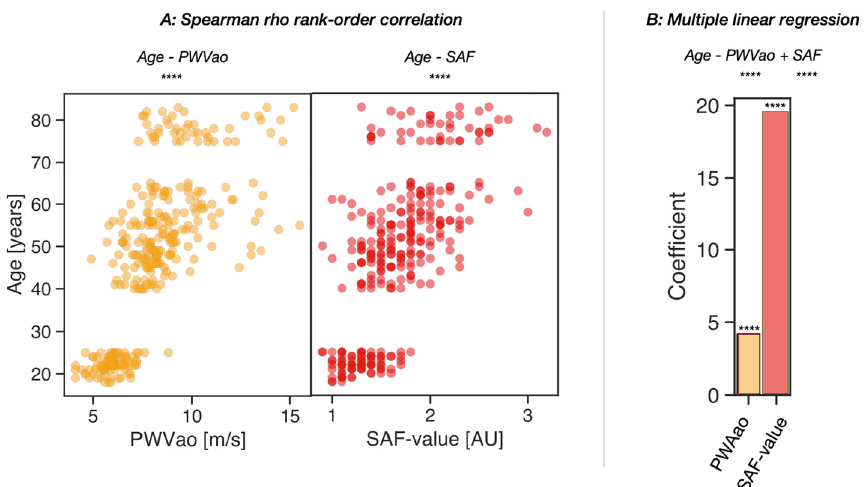
Figure 1. Associations between age and PWVao (yellow) and skin SAF value (red), respectively, in the cohort ( n = 309). ( A ) The Spearman’s correlation between age with PWVao and skin SAF value is visualized in the scatter plot. ( B ) The bar plot reveals the contributions and the association signif- icances of the independent variables, PWVao and SAF value, with the dependent variable, age, in a multiple linear regression model. Signi fi cances is given as ****: p ≤ 1.00 × 10 − 4 .